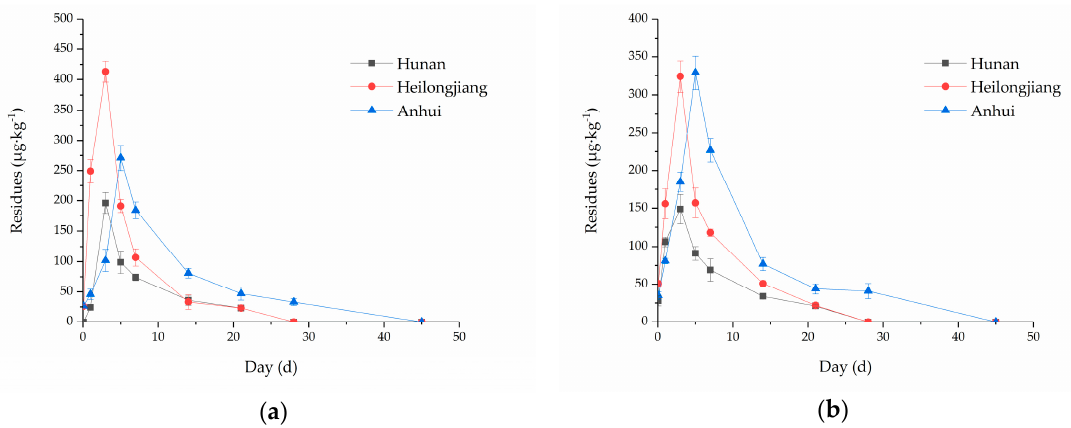
Figure 2. Dissipation curves of oxadiargyl in paddy soil for three locations (Hunan, Heilongjiang and Anhui Province) over two years described by a first order kinetic model: ( a ) 2015 and ( b ) 2016. Table 4. Dissipation, t 1/2 and correlation coefficients of oxadiargyl in paddy soil.